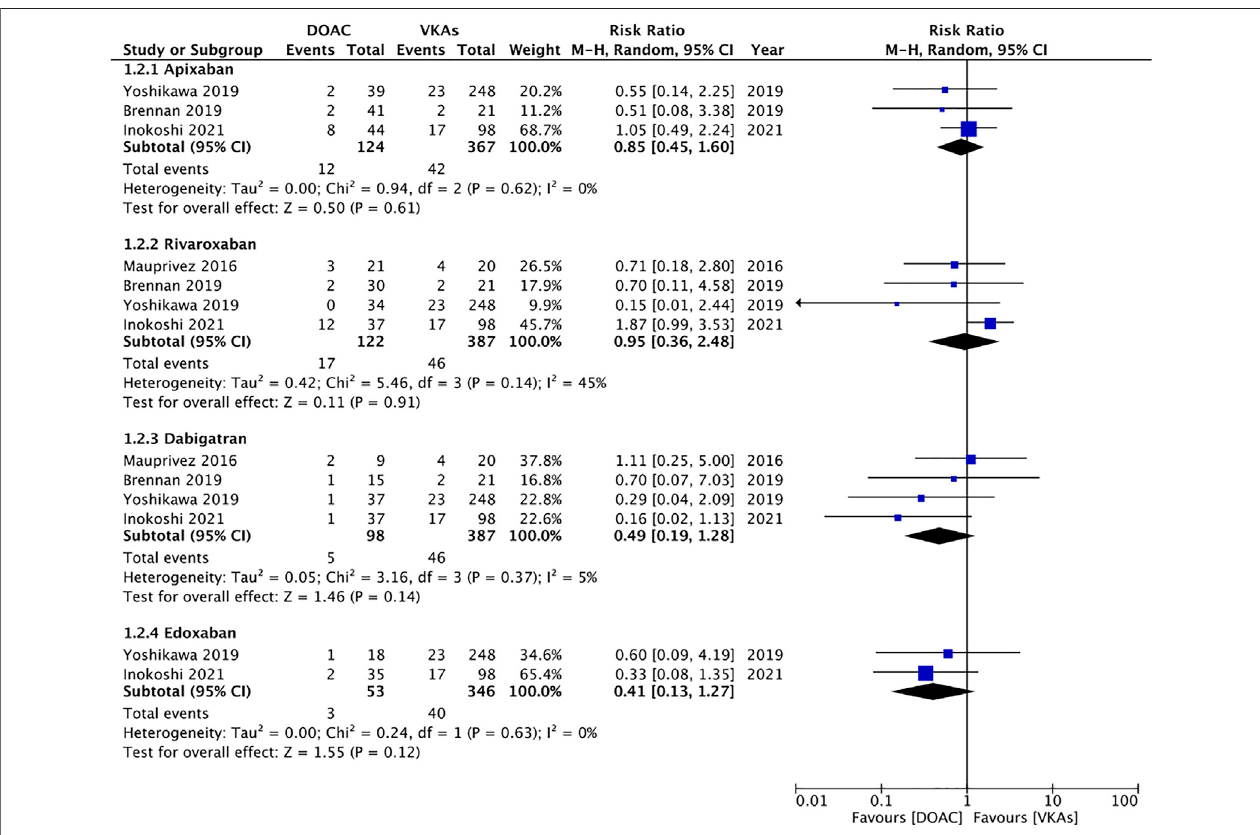
FIGURE 4 | Meta-analysis of bleeding outcomes between patients under different DOAC vs. VKAs.